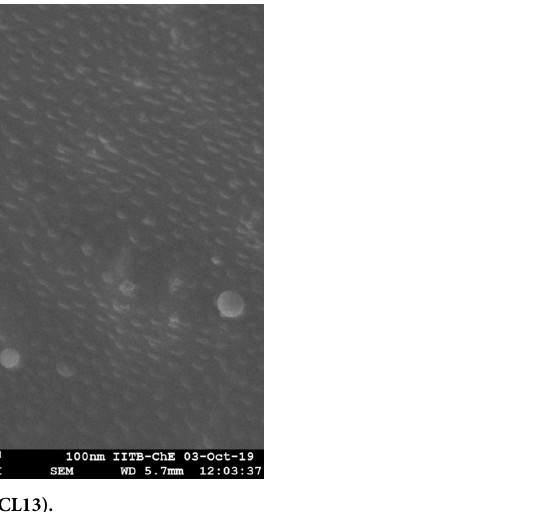
3.1.8. Differential scanning calorimetry analysis. A single sharp peak was observed cor- responding to the phase transition temperatures of drug and excipients such as at 54.9 ± 0.1˚C for DSPC, 150.5 ± 0.1˚C for cholesterol, 56.1 ± 0.1˚C for PE-PEG and at 163.24 ± 0.1˚C for CLB.